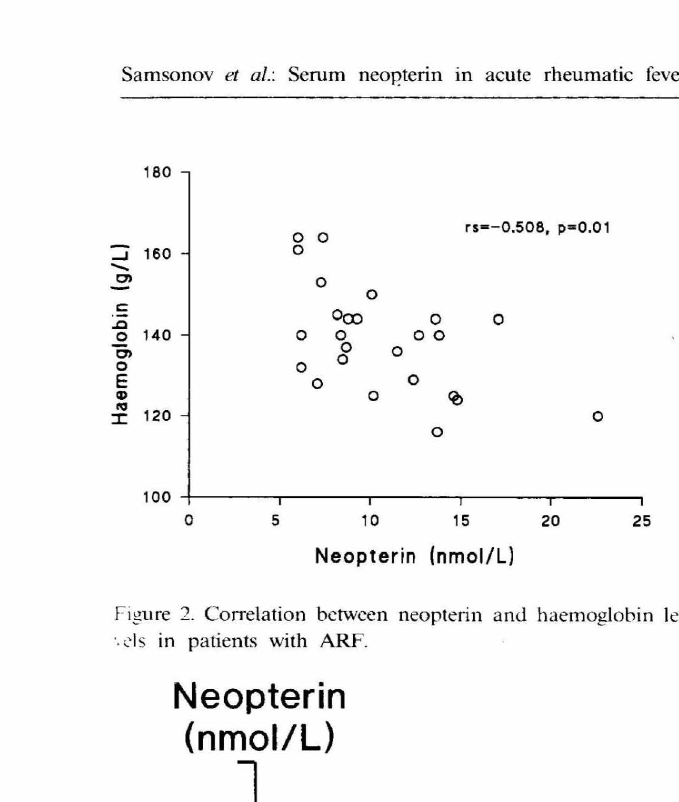
Figure 2. Correlation between neopterin and haemoglobin Ie . ds in patients with ARF.